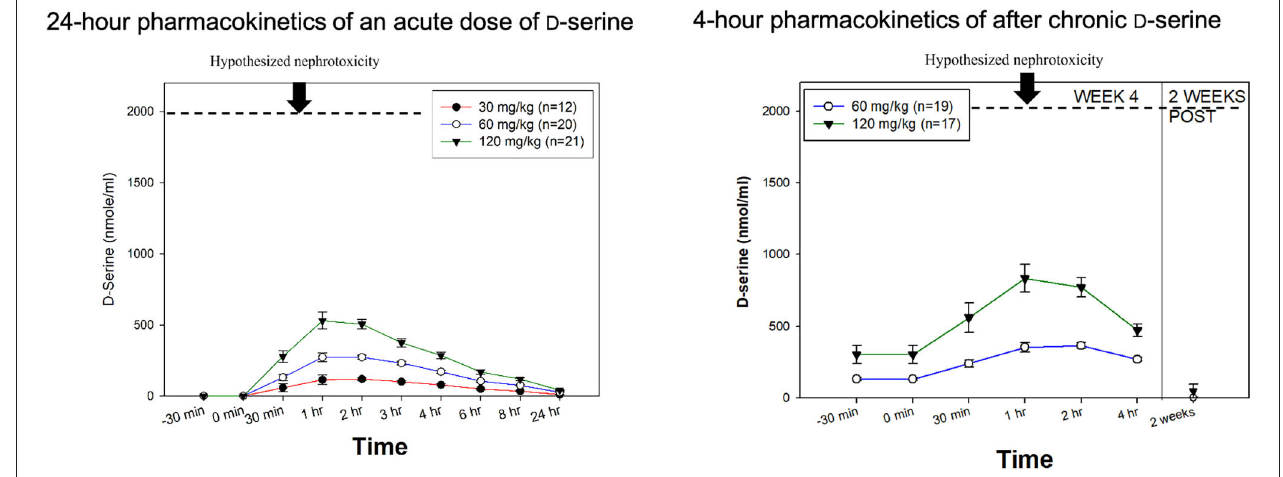
FIGURE 1 | D -serine Pharmacokinetics. (Left) 24-h pharmacokinetics of an acute dose of D -serine on day 1 of treatment. (Right) 4-h pharmacokinetics after 4 weeks of chronic dosing. In both figures, the hypothesized renal safety level is added based on experiments in rats. Modified from Kantrowitz et al. ( 31), Hasegawa et al. (108).